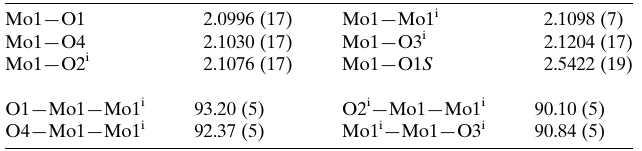
Table 1 Selected geometric parameters (A˚ , (cid:4) ).